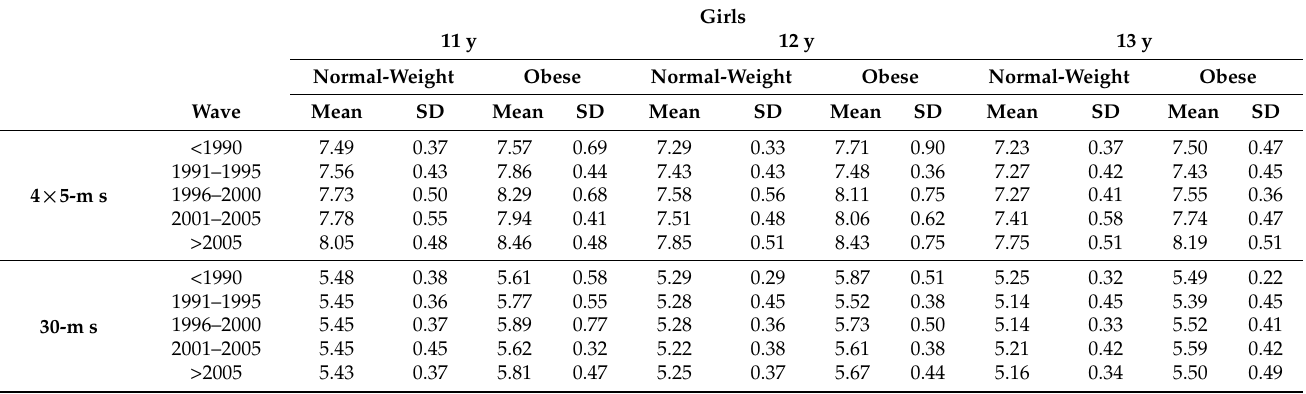
Table 3. Mean physical fitness score by body weight and wave for girls aged 11–13 y ( n =